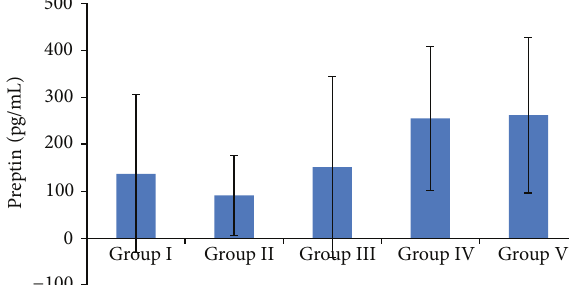
Figure 3: Serum preptin levels in relation to BMIs. Group I: low- weight; Group II: normal-weight; Group III: overweight; Group IV: obese;GroupV:morbidlyobese. 𝑃 < 0.005 forGroupIversusGroup II versus Group III versus Group IV and Group V.